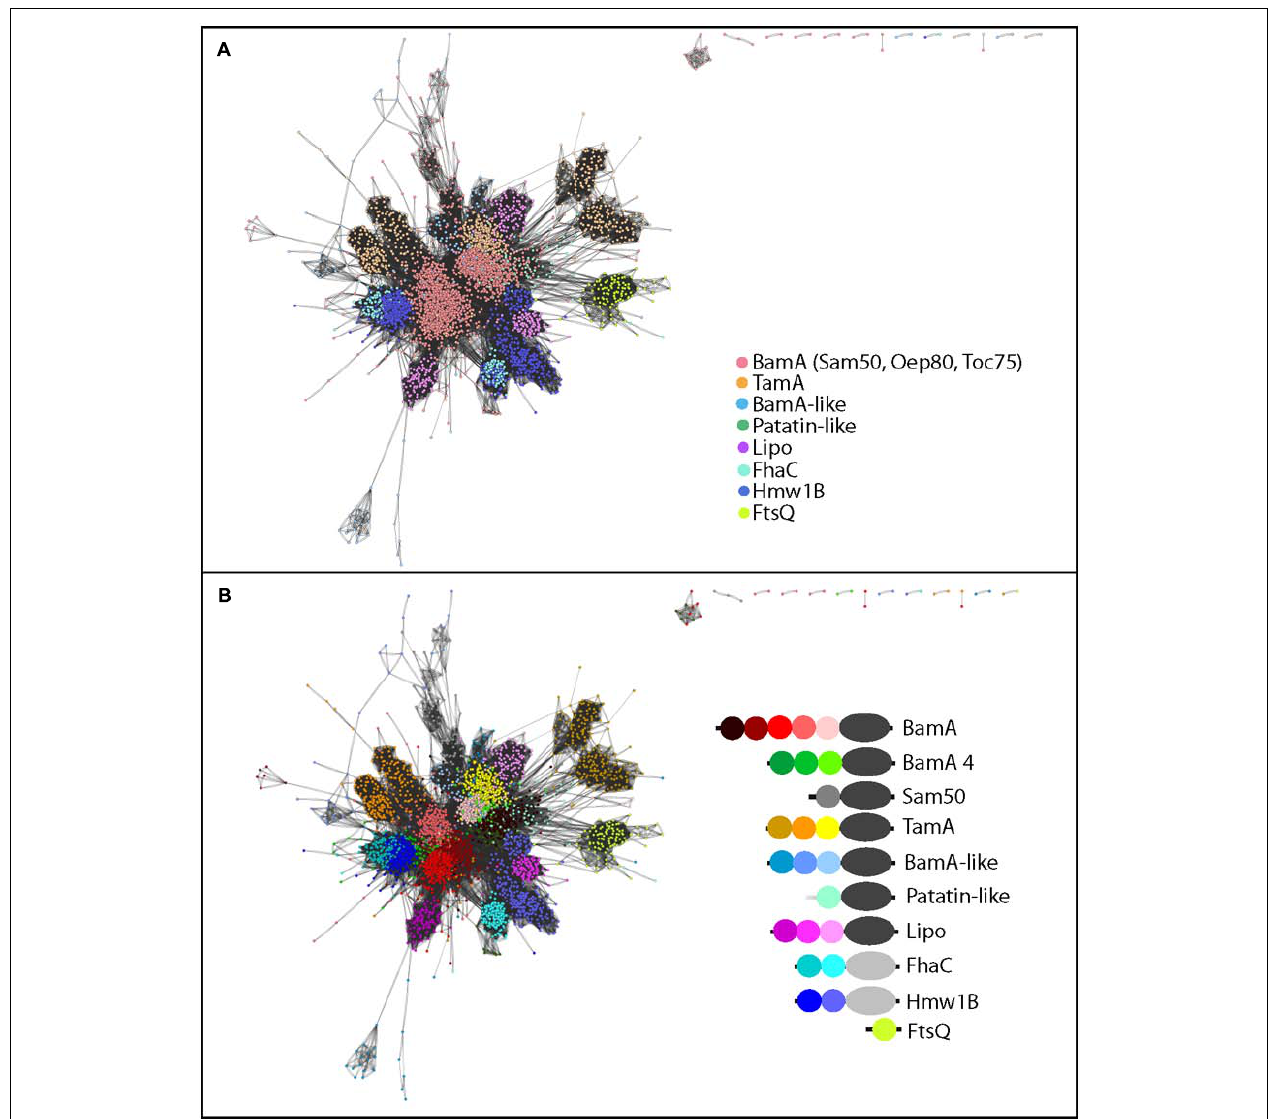
FIGURE 4 | Sequence similarity network of POTRA domains highlights diversity based on subfamilies as well as the location of the POTRA respective to the barrel. (A) Protein-protein similarity network representation of POTRA domain sequences, where the colors depict the different subfamilies. (B) Recolouring of (A) as indicated; with each POTRA